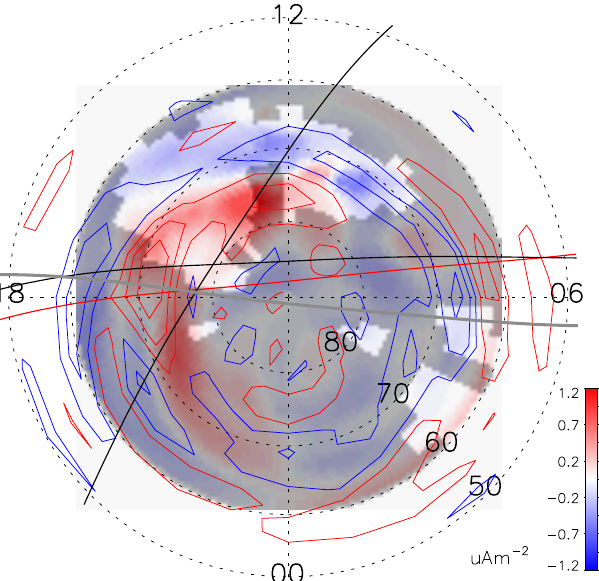
Fig. 13. Birkeland currents, J calculated from the satellite mag- k netic perturbation data for 3 October, 2003 as shown in Fig. 12 us- ing Eq. (12). The parameters used in the SCHA were θ c = 50 ◦ , k =15 and m =5.